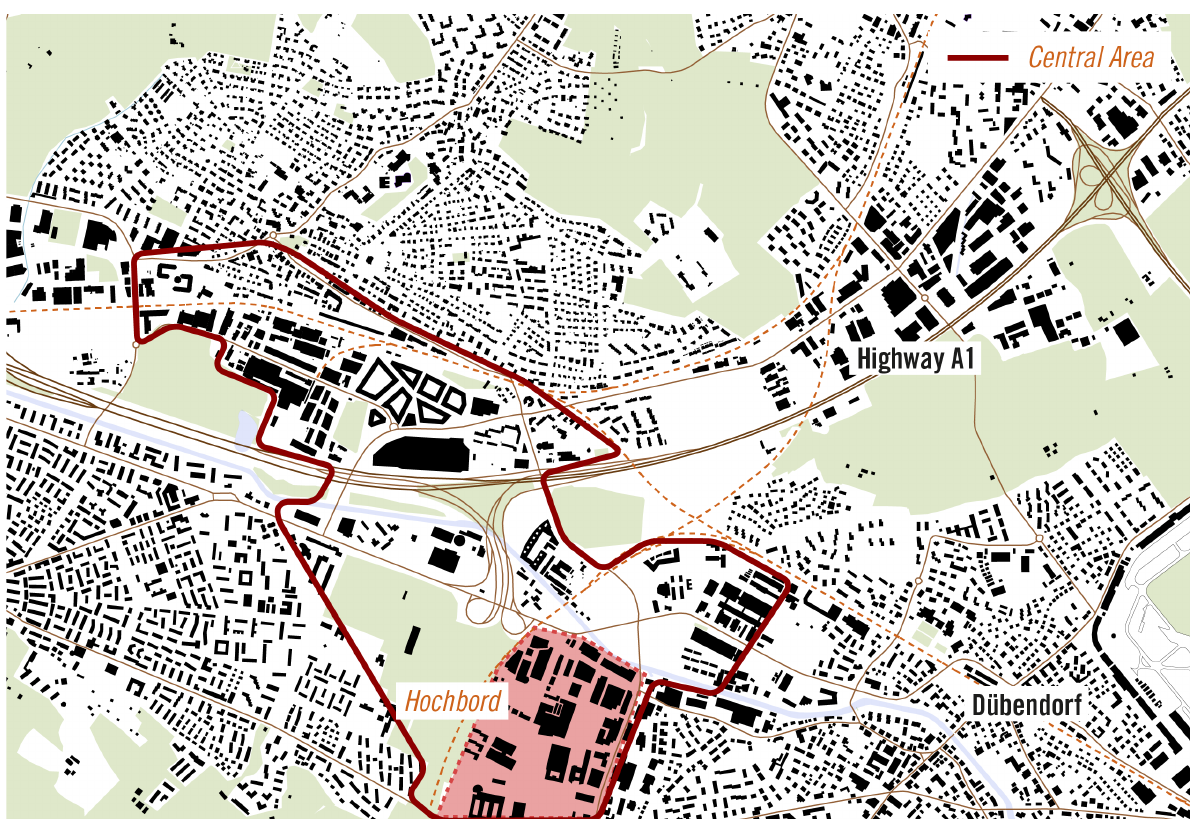
Figure 4. Definition of central areas in the Glatttal including the area of Hochbord in Dübendorf. Source: